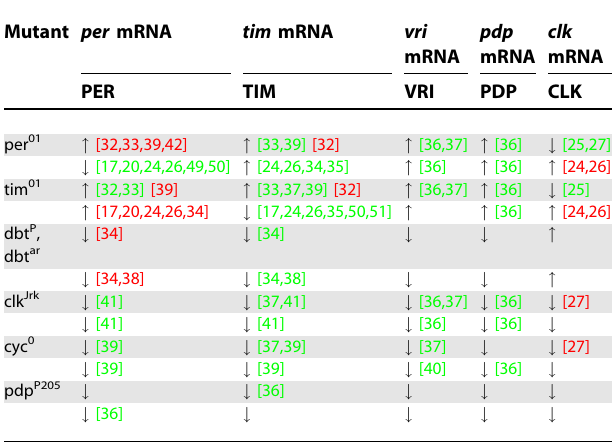
Notes: Peak expression levels for mRNA and protein are listed relative to wild-type maxima: non-detectable to half-peak levels ( # ), or greater than half-peak level ( " ). References (in brackets) in green are consistent with the model results, red references are not.